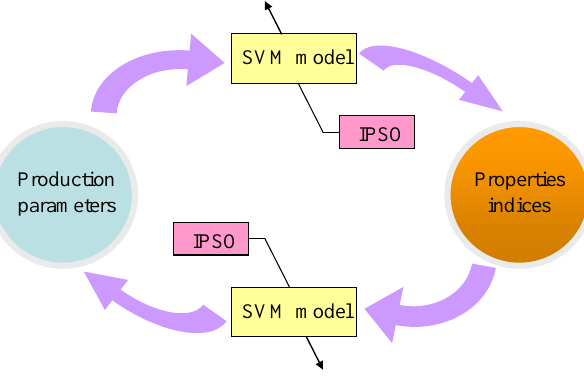
Figure 2. Bidirectional prediction model of carbon fiber